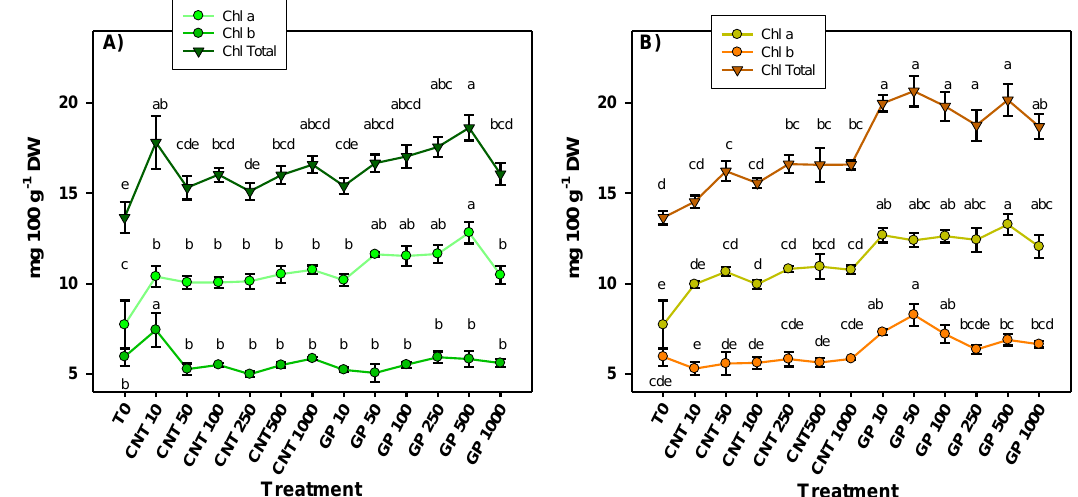
Figure 2. Photosynthetic pigments in tomato seedlings treated with carbon nanomaterials applied via foliar ( A ) and drench ( B ). Chl a: chlorophyll a; Chl b: chlorophyll b; Chl Total: sum of chlorophyll a + chlorophyll b; T0: control; CNTs: carbon nanotubes; GP: graphene; DW: dry weight; 10, 50, 100, 250, and 500 represent the mg L − 1 applied of each carbon nanomaterial. Different letters indicate significant differences among treatments according to Duncan ( α = 0.05). n = 5 ± standard error.